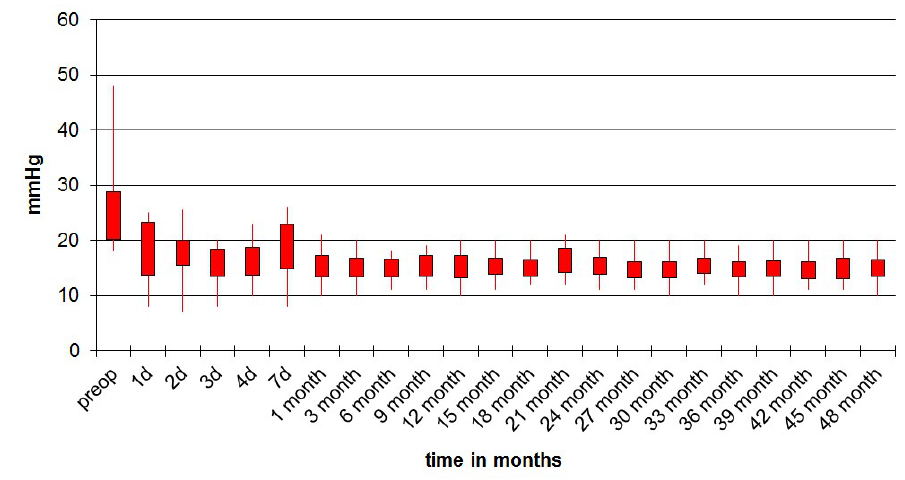
Figure 6. Intraocular pressure (IOP) follow-up of operated eyes during 48 months.